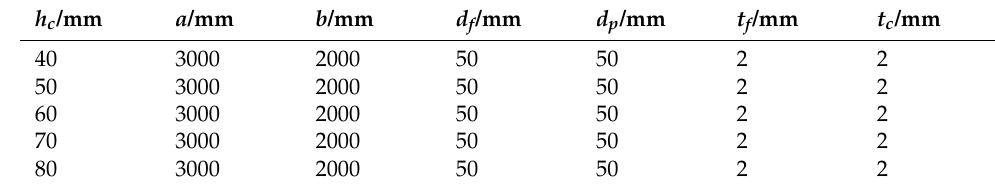
Table 6. Geometric parameters of the I-type corrugated sandwich panel with rectangular